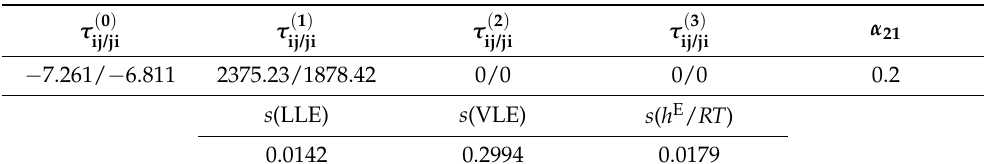
Table 1. Parameters of NRTL obtained using AspenPlus ® for the binary methyl methanoate (1) + pentane (2).